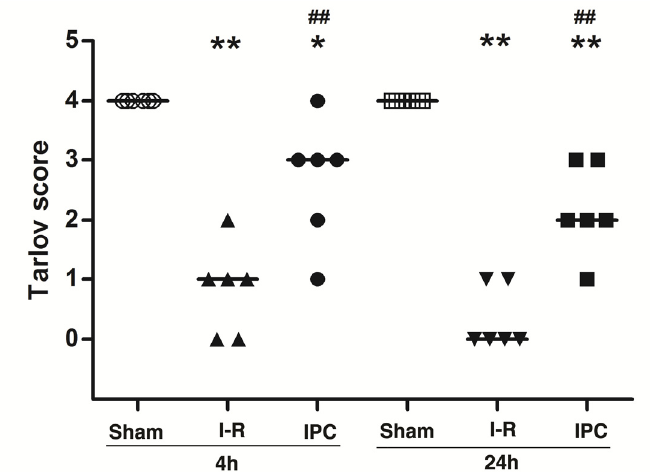
Figure 1. IPC improved neurologic function after spinal cord ischemia-reperfusion (I-R) injury. Neurologic function was assessed using Tarlov scores at 4 and 24 h after spinal cord ischemia. Data are presented as individual values for each animal, as well as median values for each group ( n = 6/group). ** p < 0.01 versus Sham group. ## p < 0.01 versus I-R